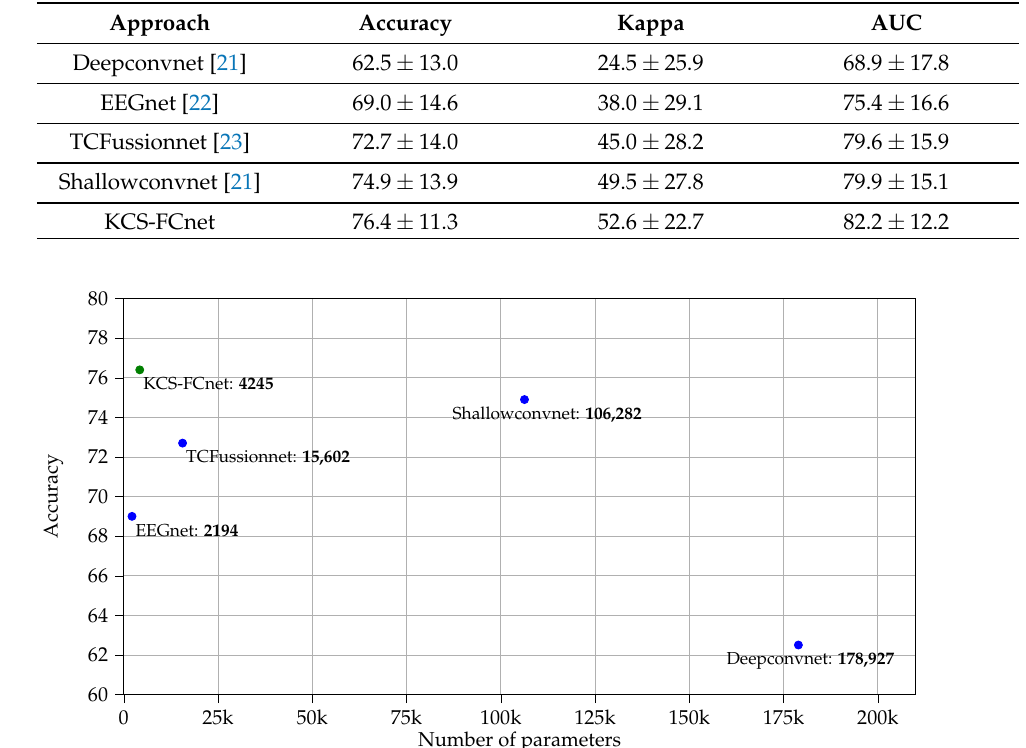
Figure 10. Method comparison results: number of trainable parameters vs. average motor imagery classification accuracy for the Giga